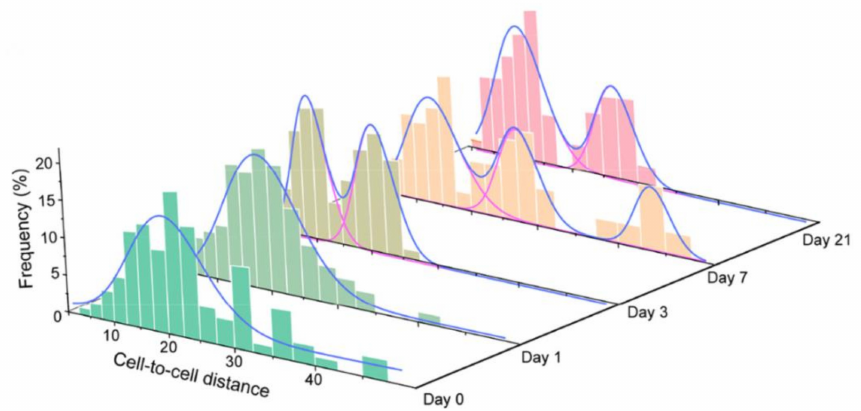
Figure 4. The histograms and Gaussian-fitted curves of intercellular Euclidean distances under adipogenic medium. Red violet lines: isolated peaks; blue lines: peak sums